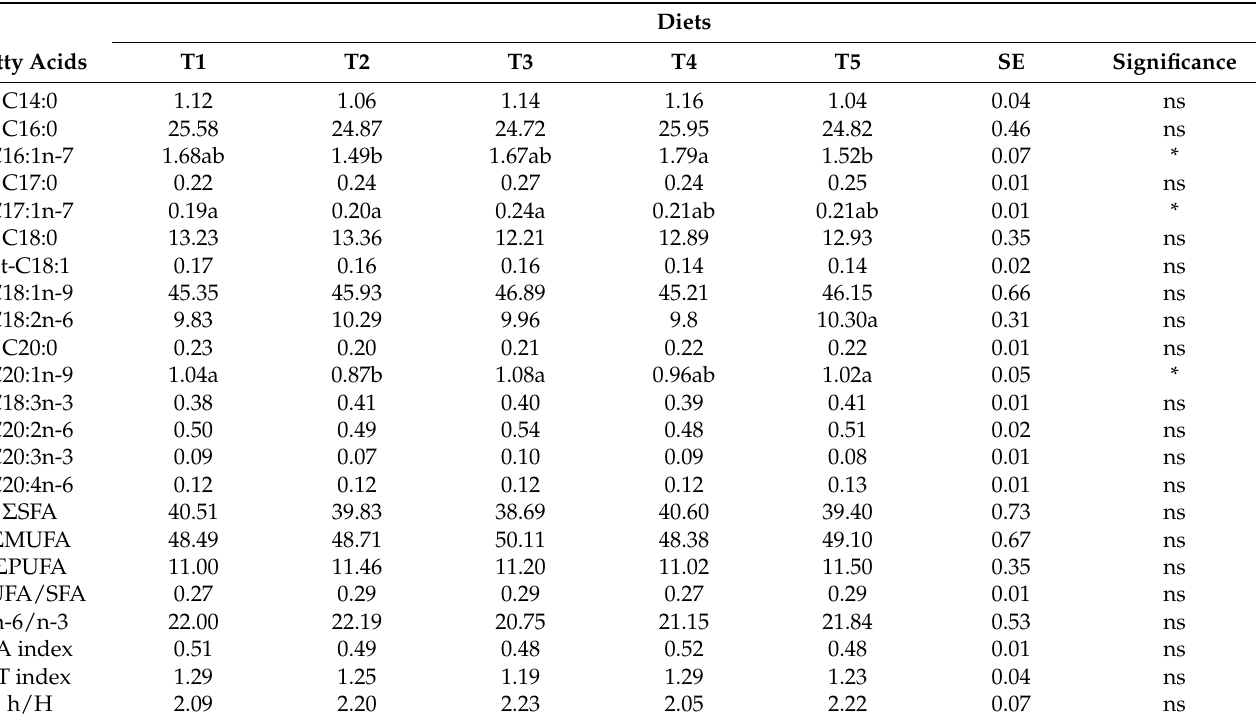
Table 6. Fatty acid profile of backfat from the B í saro pig breed. Effect of treatment with olive cake.